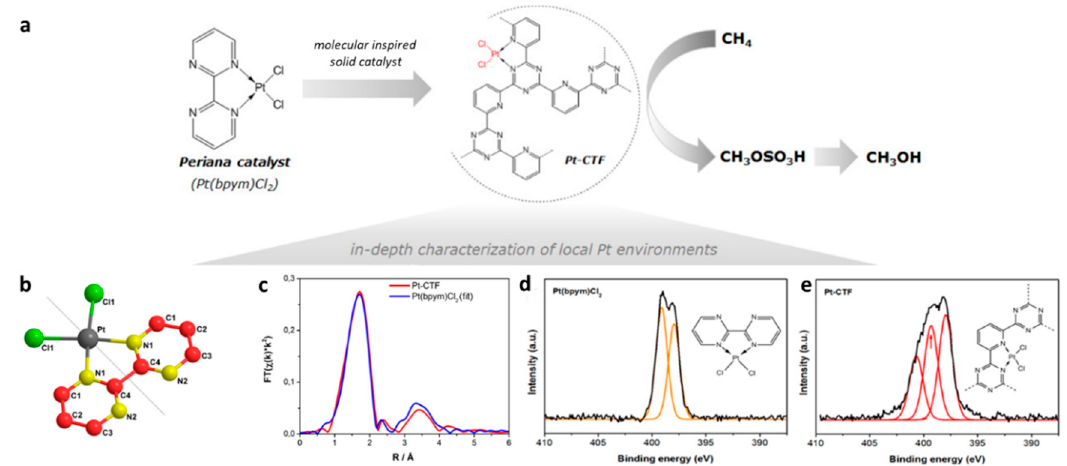
Figure 3. ( a ) Schematic diagram of the molecular Pt-CTF catalyst having a similar coordination environment as the molecular Periana catalyst (Pt(bpym)Cl 2 ) for the oxidation of methane to methanol in concentrated sulfuric acid; ( b ) Structural model of Pt(bpym)Cl 2 ; ( c ) EXAFS analysis of Pt-CTF and the fitted theoretical Pt(bpym)Cl 2 model; ( d ) XPS N 1s spectra of Pt-modified 2,2 ′ -bypyrimidine ligand and ( e ) XPS N 1s spectra of Pt-modified CTF (Adapted with permission from [39]. Copyright 2016, American Chemical Society).